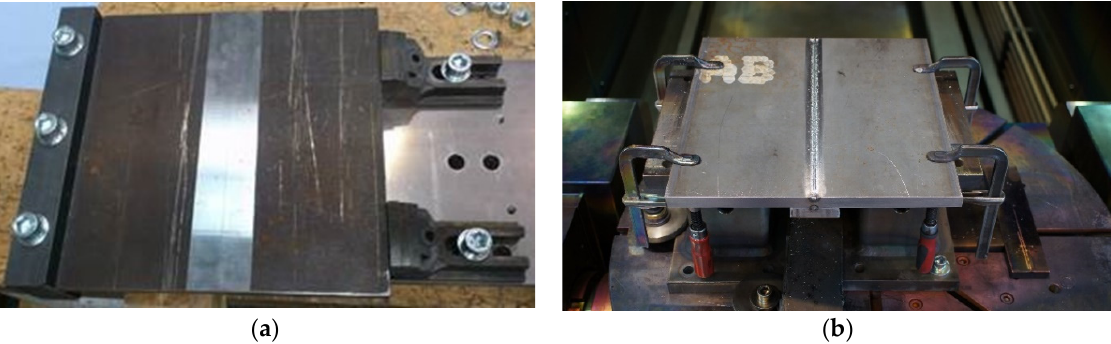
Figure 2. ( a ) Clamping device; ( b ) Clamp configuration in EB welding of S960QL specimen.